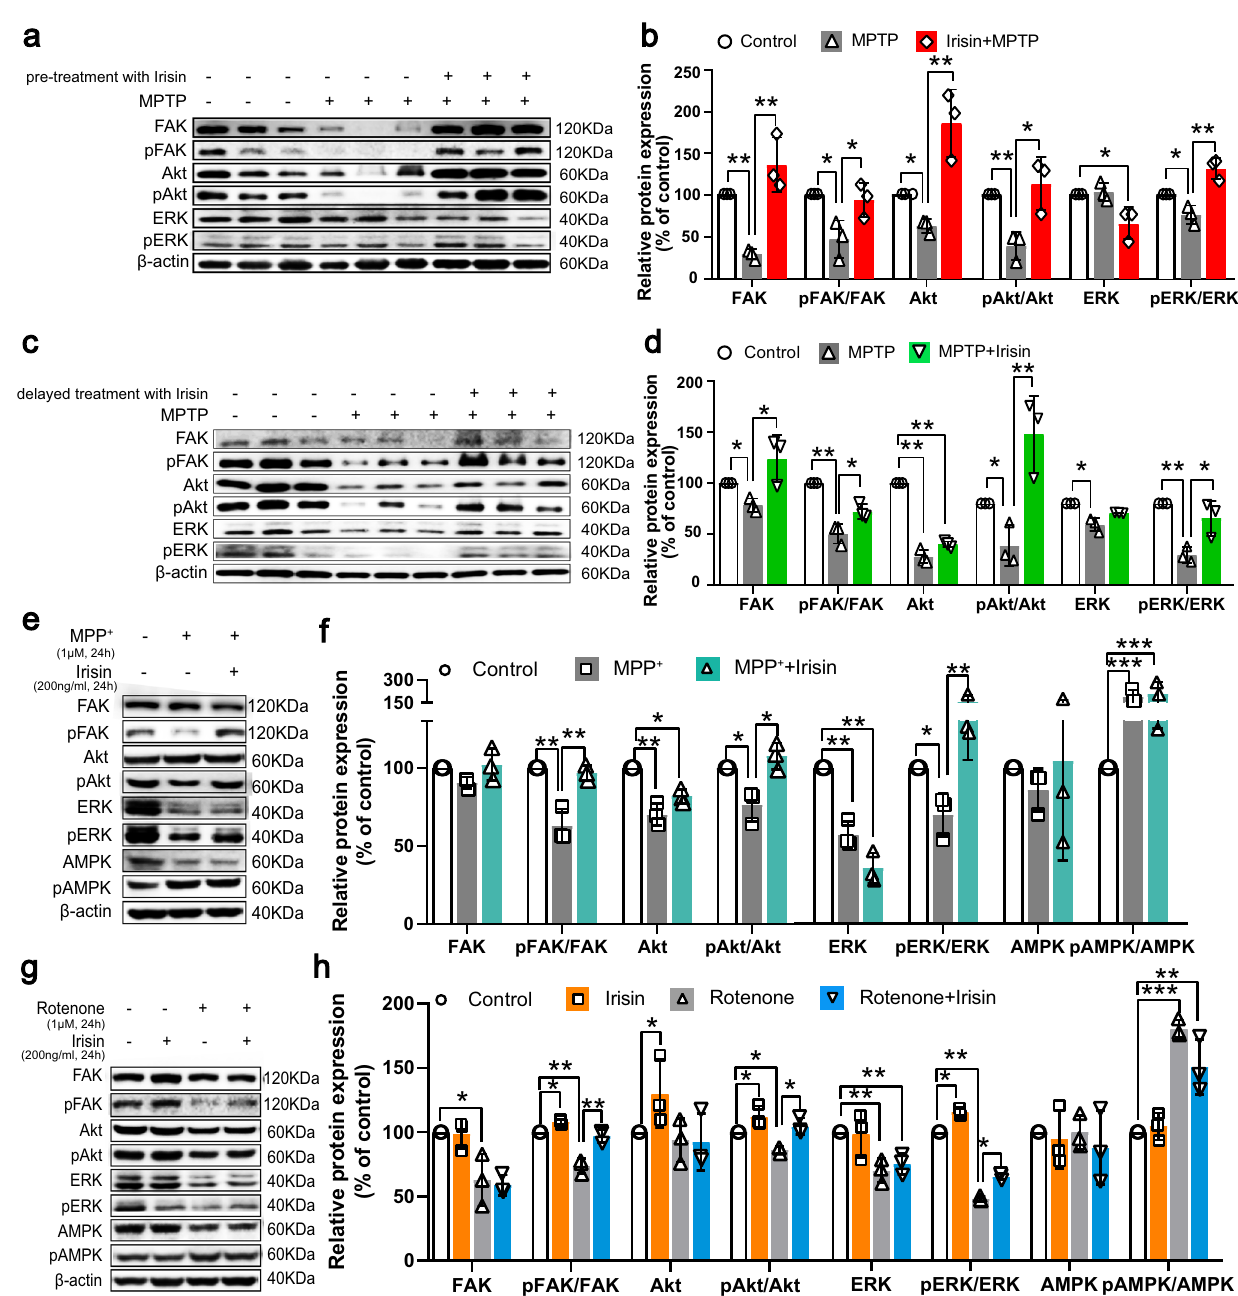
Fig. 6 Irisin activate integrin receptor signaling pathway. a , b Western blot showing the quanti fi cation of the p-FAK/FAK ratio, p-Akt/Akt ratio, p-ERK/ERK ratio in each group of MPTP treated mice receiving pre-treatment with irisin. c , d Western blot showing the quanti fi cation of the p-FAK/FAK ratio, p-Akt/Akt ratio, p-ERK/ERK ratio in each group of MPTP treated mice receiving delayed treatment with irisin. e , f Western blot showing the quanti fi cation of the p-FAK/FAK ratio, p-Akt/Akt ratio, p-ERK/ERK ratio, and p-AMPK/AMPK ratio in each group of SH-SY5Y cells treated by irisin and MPP + . g , h Western blot showing the quanti fi cation of the p-FAK/FAK ratio, p-Akt/Akt ratio, p-ERK/ERK ratio, and p- AMPK/AMPK in each group of SH-SY5Y cells treated by irisin and rotenone. All data are presented as mean ± SEM ( n ≥ 3). ∗ p < 0.05, ∗∗ p < 0.01, and ∗∗∗ p < Mitochondria constantly undergo the balance of fusion and fi ssion to maintain mitochondrial homeostasis 40,41 . The mitochon- drial fusion in inner mitochondrial membrane is regulated by OPA1, whereas MFN1 and MFN2 is required for outer mitochon- drial membrane fusion. Mitochondrial fi ssion is controlled by protein level and phosphorylation modi fi cation of DRP1 64 . Phosphorylation of DRP1 at Ser616 increases mitochondrial fi ssion, whereas phosphorylation at Ser637 reduces mitochondrial fi ssion.